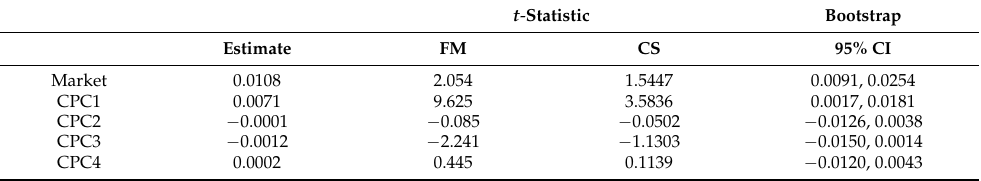
Table 11. Results for Cross-Sectional estimation of Model 2.